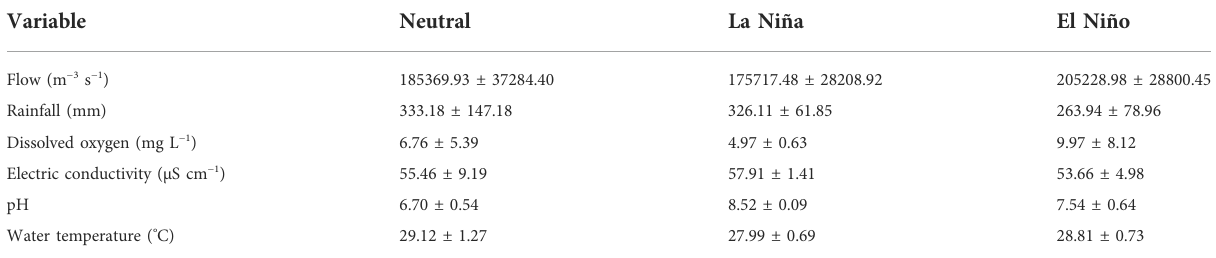
TABLE 1 Mean and standard deviation values of the fl ow and limnological variables of the lower Amazon River between three periods (neutral, La Niña, and El Niño).